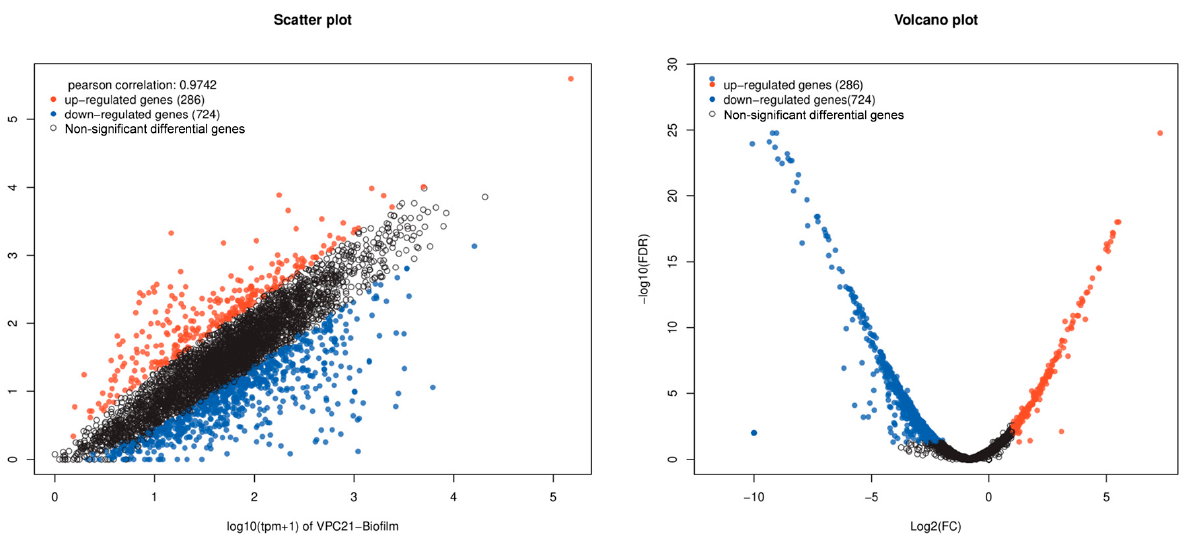
Figure 5. Visual scatter plot and volcano plot of V. parahaemolyticus transcriptome differential ex- pression gene. Note: The red dots represent genes that are significantly upregulated, the blue dots represent genes that are significantly downregulated, and the black dots represent genes that are not signi fi cantly di ff erent.